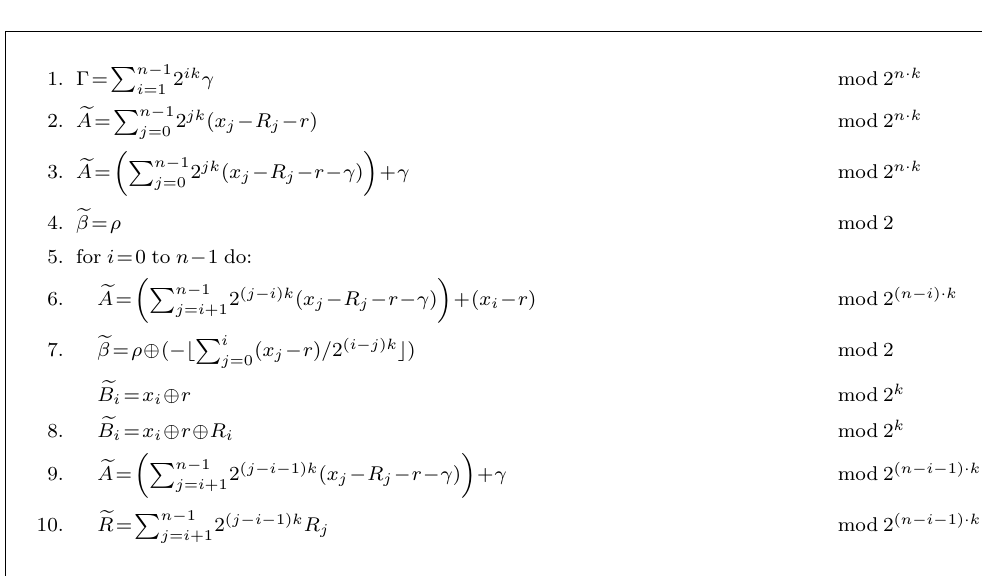
Figure 6: Intermediate values of all variables used in Algorithm 11. Variables with tilde e · are intermediate values, variables without are fixed input